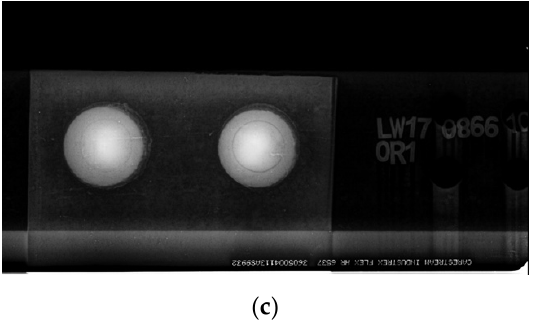
Figure 14. Riveted joint ( a ) sample as collected, ( b ) cut-through section and ( c ) radiographic image.